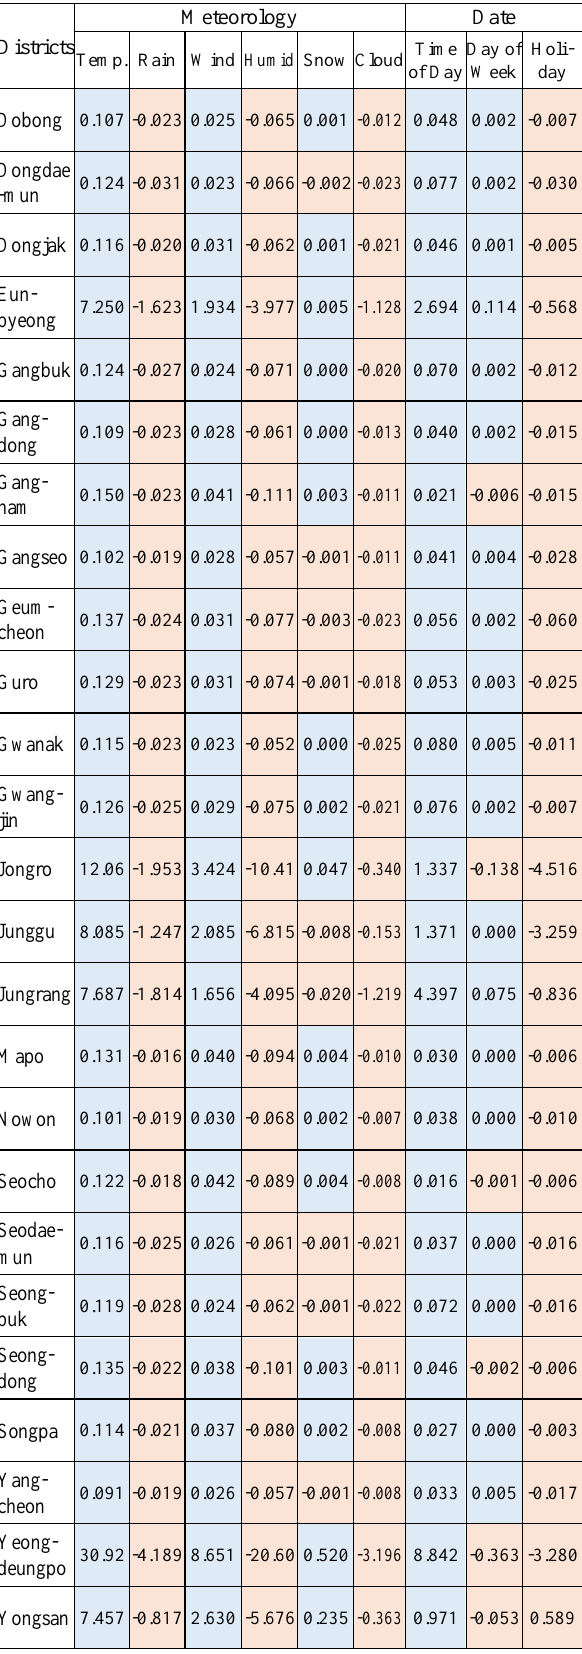
Table 3 . Estimation Results of Correlation between Bike Use and Social Environmental Data by District in Seoul